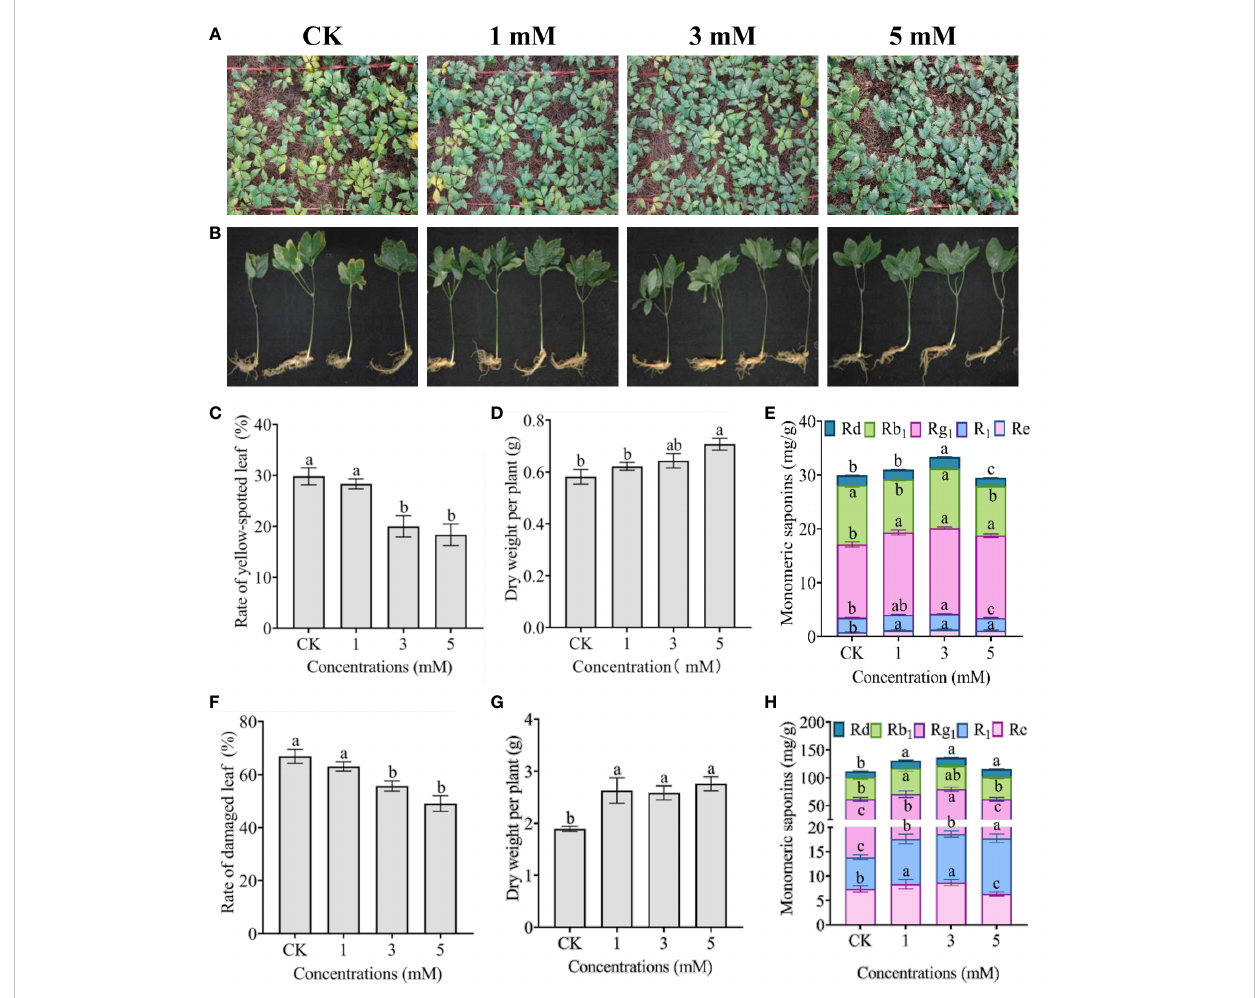
FIGURE 6 Effect of exogenous foliar leucine on the biomass and PNSs in P. notoginseng under heat stress in the fi eld. (A, B) Morphological responses of one- and two-year-old P. notoginseng treated with sterilized deionized water (CK) and exogenous leucine at concentrations of 1, 3 and 5 mM once every three days under heat stress for 30 days in the fi eld, respectively. (C, F) Changes in the damaged leaf rate of one- and two-year-old P. notoginseng , respectively. (D, G) Changes in the dry weight of one- and two-year-old P. notoginseng per plant, respectively. (E, H) Changes in the PNSs contents in one- and two-year-old P. notoginseng rhizomes and roots, respectively. Error bars indicate the standard error (SE) calculated from six biological replicates. Different letters indicate statistically signi fi cant differences among the treatments by Duncan ’ s multiple range test at p <